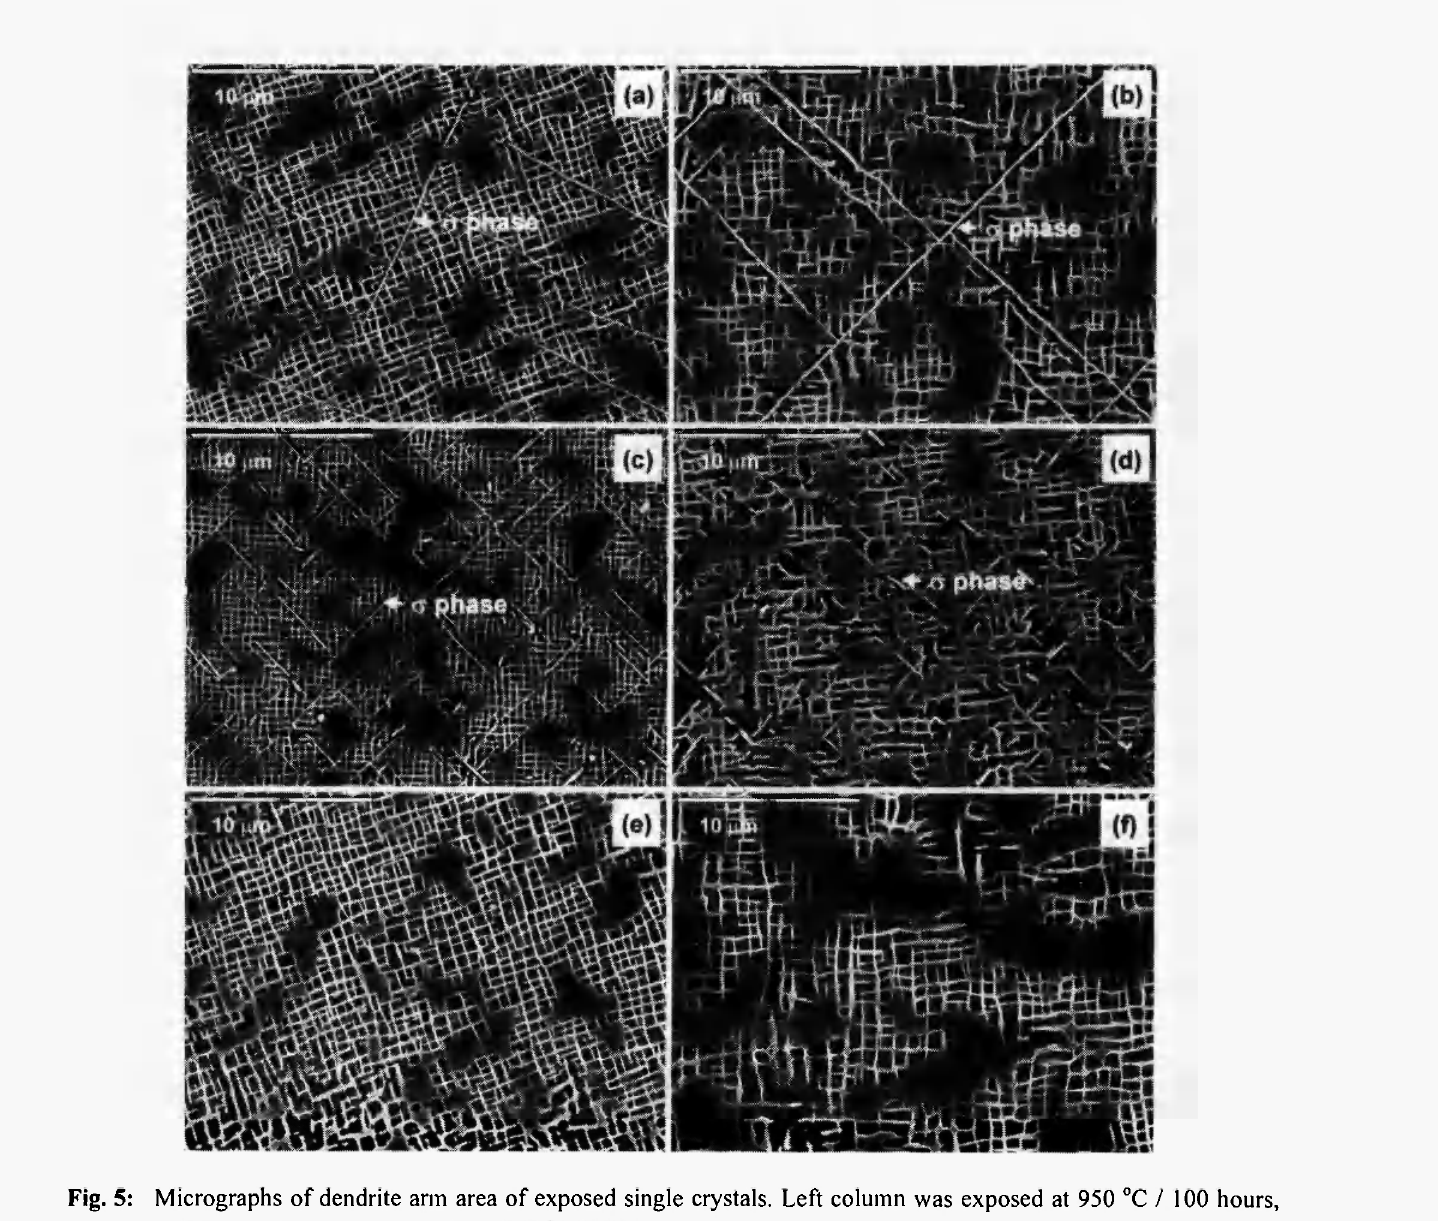
Fig. 5: Micrographs of dendrite arm area of exposed single crystals. Left column was exposed at 950 °C / 100 hours, and right column was exposed at 1050 °C / 100